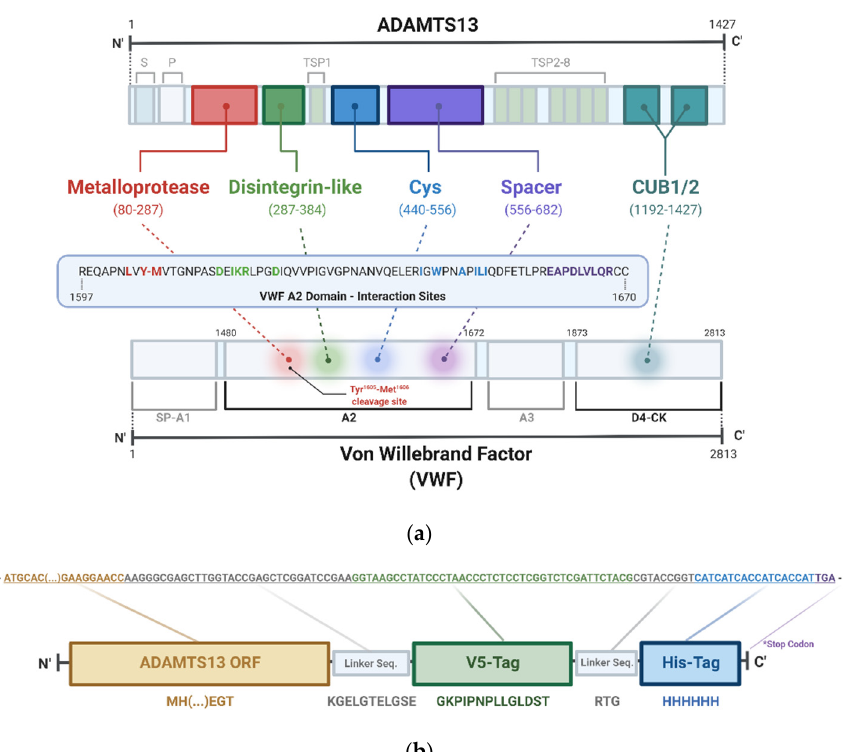
Figure 1. Structure and Domain Interactions of ADAMTS13 with VWF. ( a ) The ADAMTS13 CUB1/2 domains (cyan) bind the D4 ‐ CK domains of VWF. This allows ADAMTS13 to form an open conformation, whereby exosites, present within the Disintegrin ‐ like (green), Cys (blue), and Spacer (purple) domains interact with sites within the A2 domain of VWF. Interaction with VWF via the disintegrin ‐ like domain allosterically activates ADAMTS13 ′ s metalloprotease domain (red) to cleave VWF at the Tyr1605 ‐ Met1606 bond. ( b ) ADAMTS13 construct with V5 ‐ His ‐ tag at the C ‐ terminal end with DNA sequences (top) and amino acid sequences (bottom) shown. Created with Biorender.com (accessed on January 27, 2022).